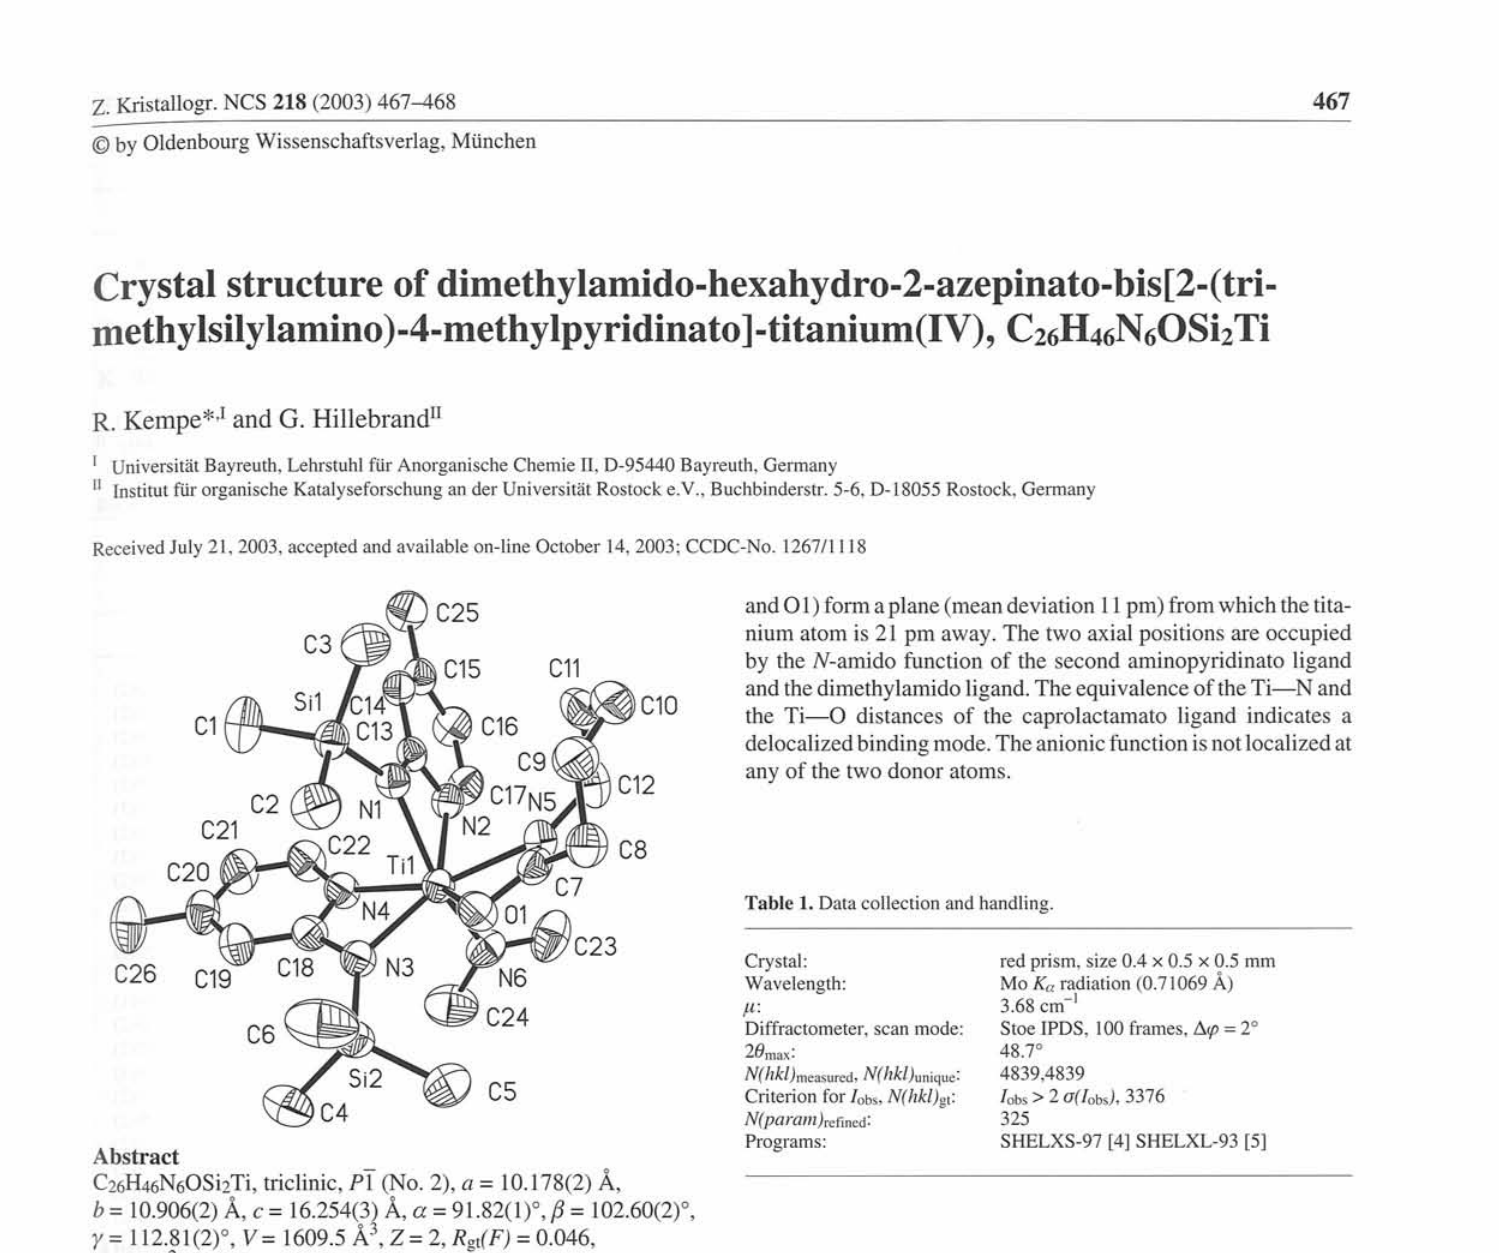
Table 2. Atomic coordinates and displacement parameters (in A